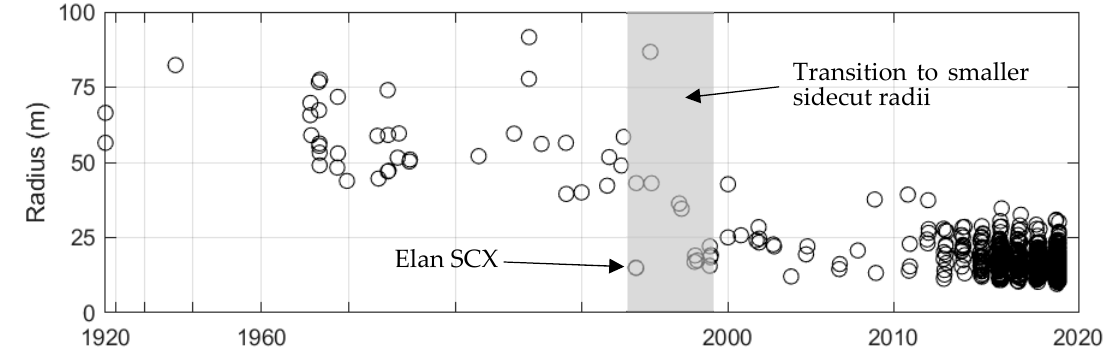
Figure 2. Ski length vs. model year.